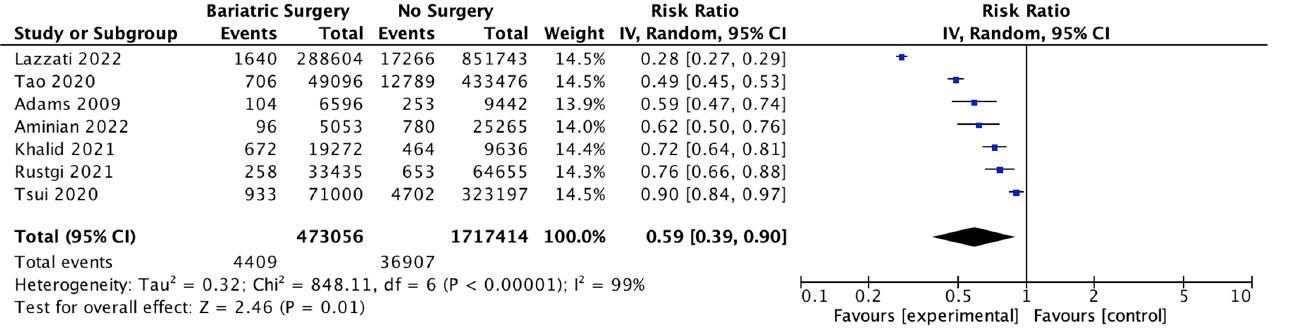
Figure 4. Incidence of obesity-associated cancers (OAC)